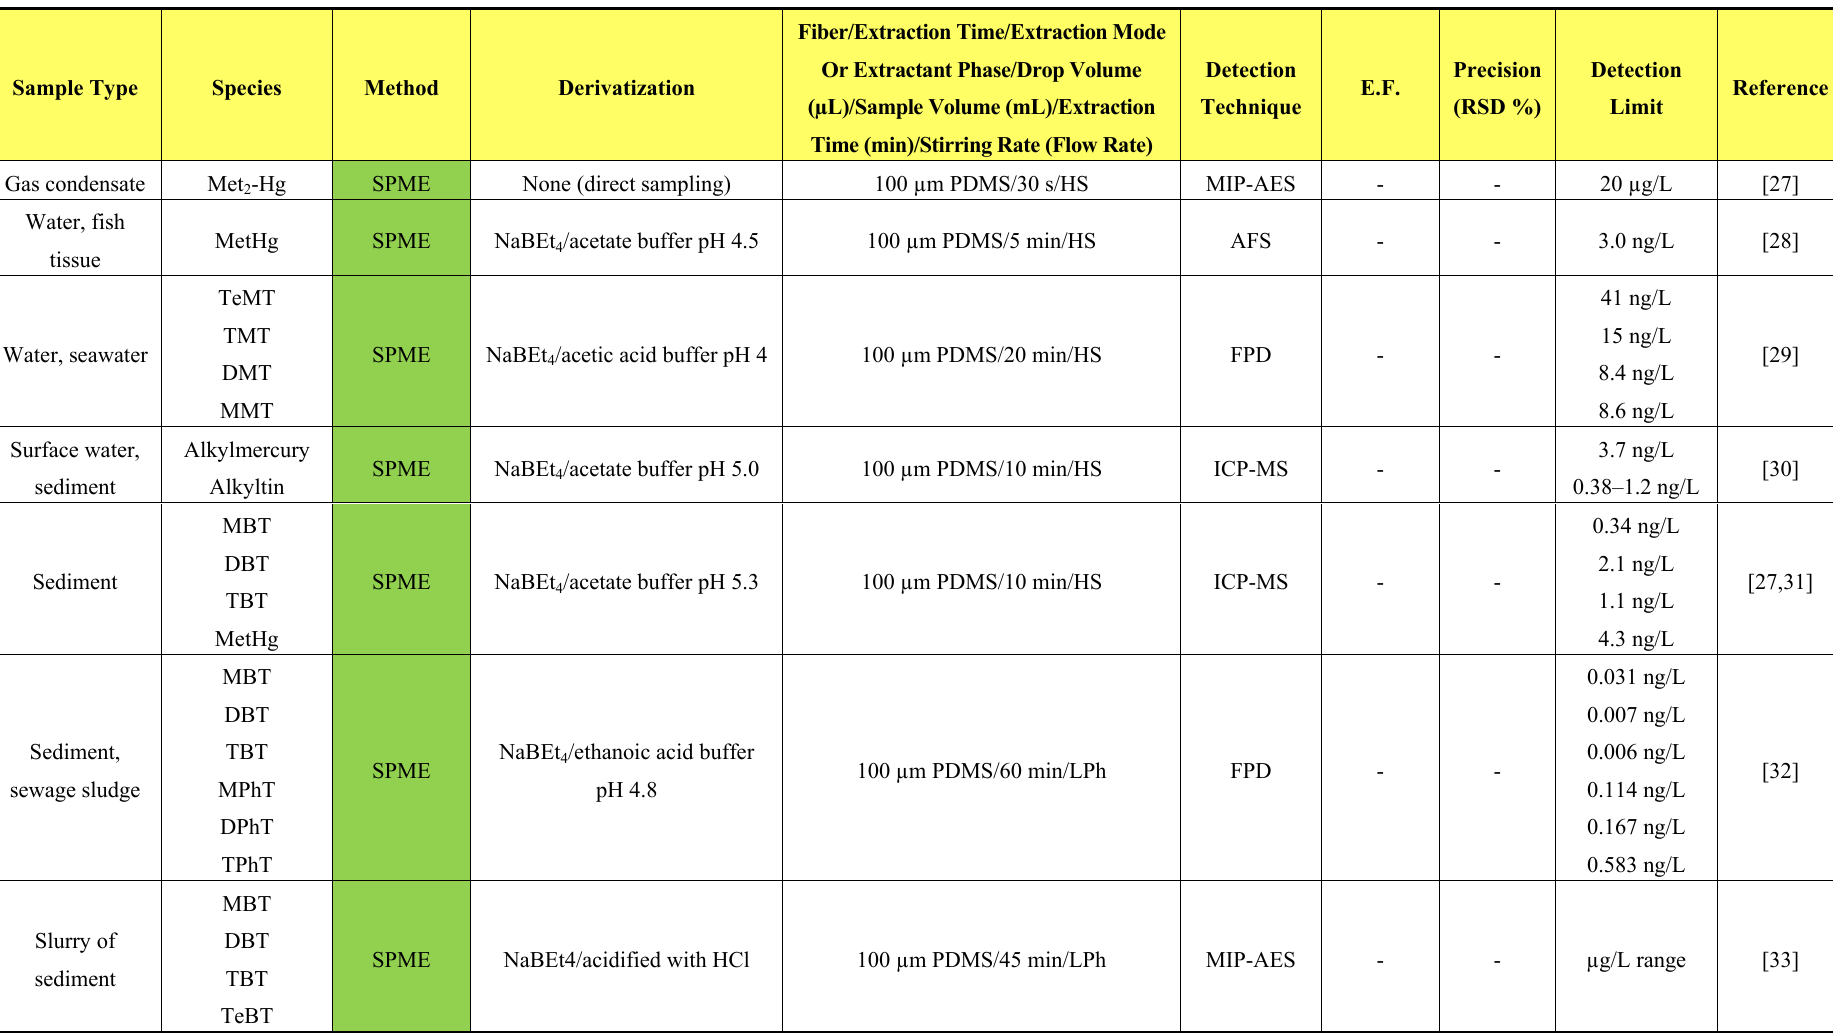
Table 2. Examples of application of selected microextraction techniques for analyte sampling before the determination of various forms of tin and